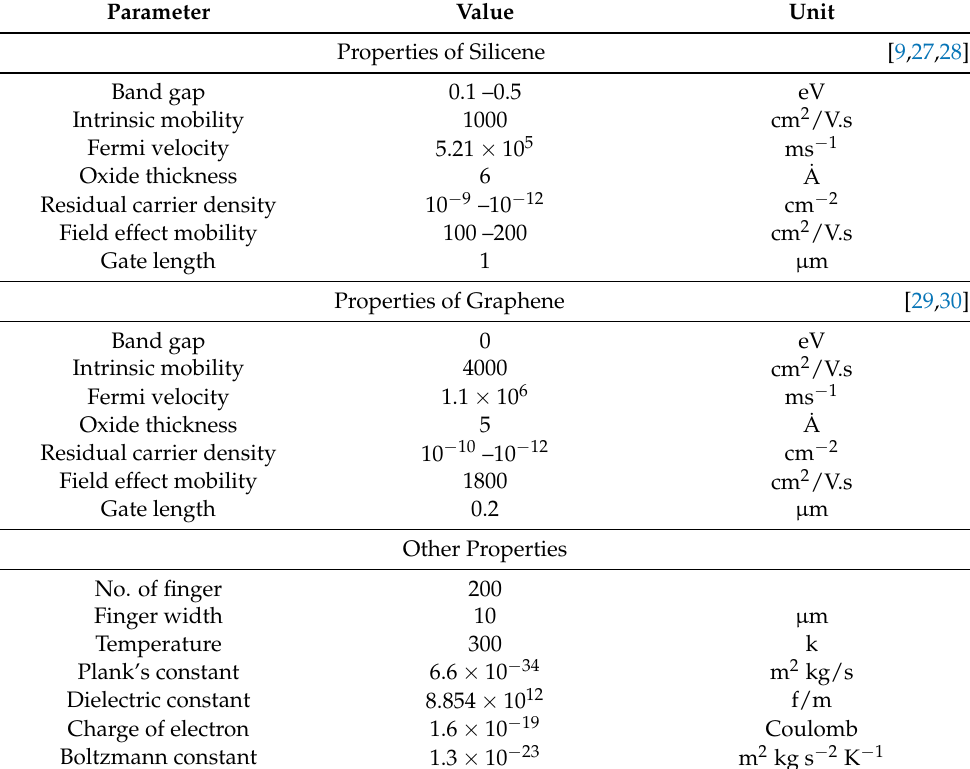
Table 1. Simulation